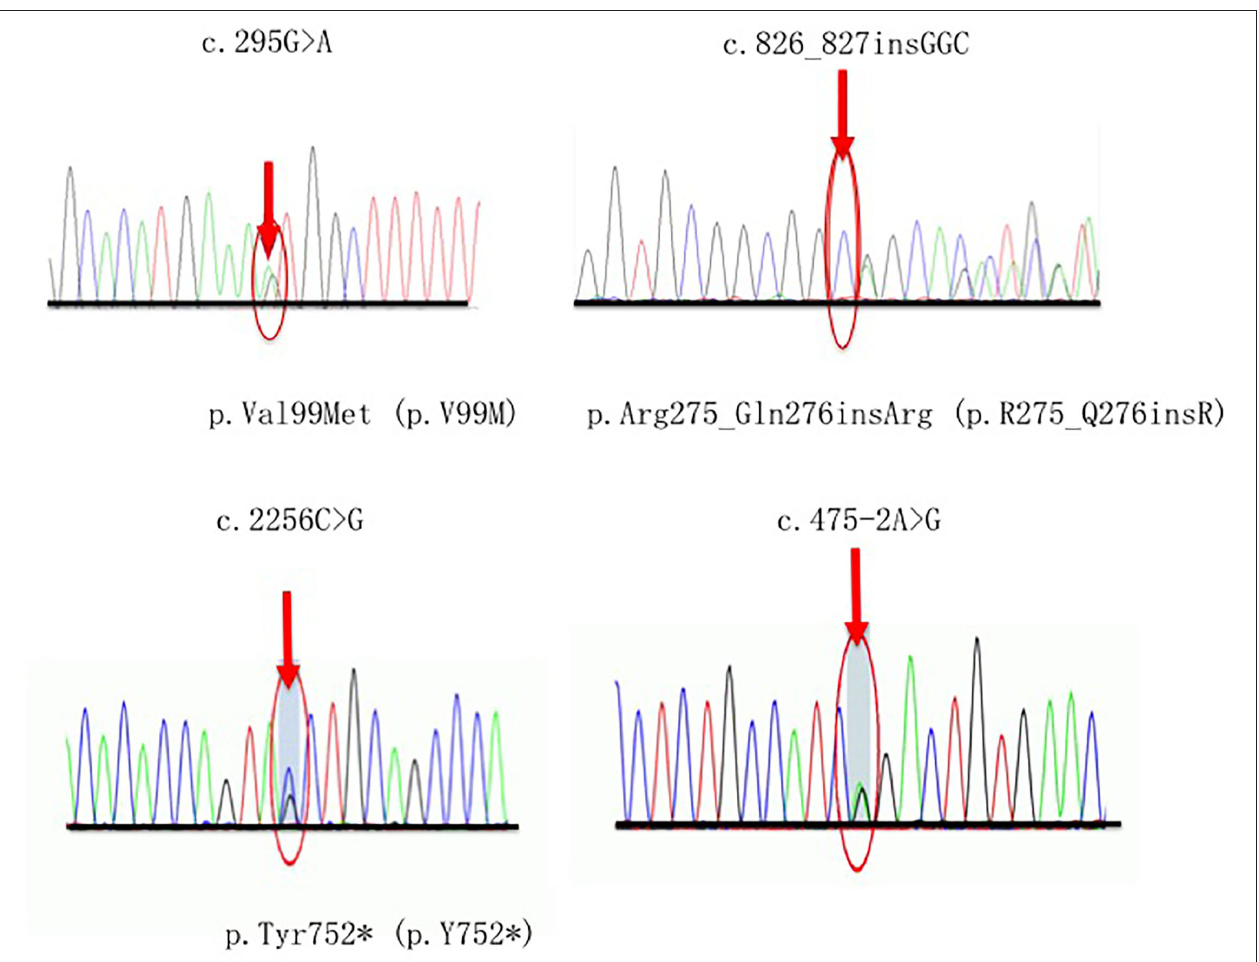
FIGURE 2 | Sequencing chromatograms of four novel variants. Red arrows indicate the mutation site.